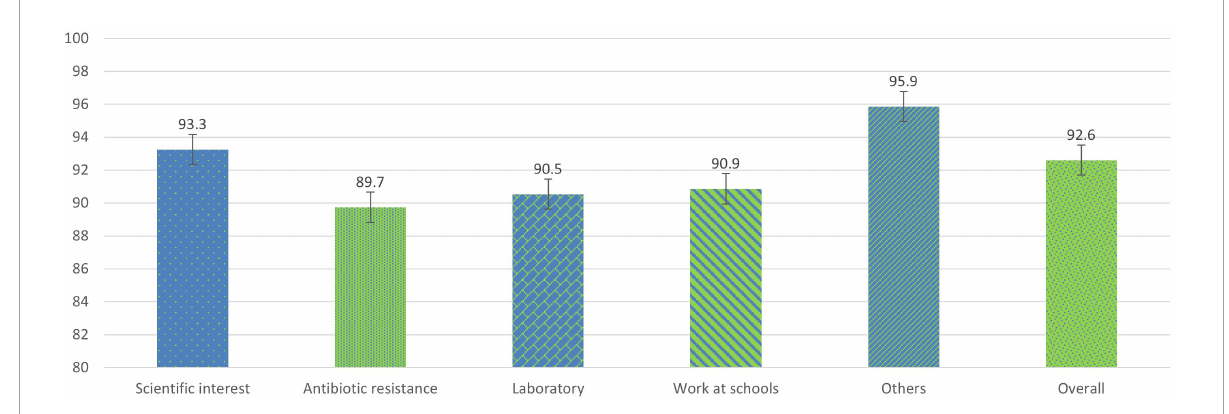
FIGURE4 Percentages of the average satisfaction values of each general section in university students at the end of the SWICEU project during the 2017–2021 academic years.